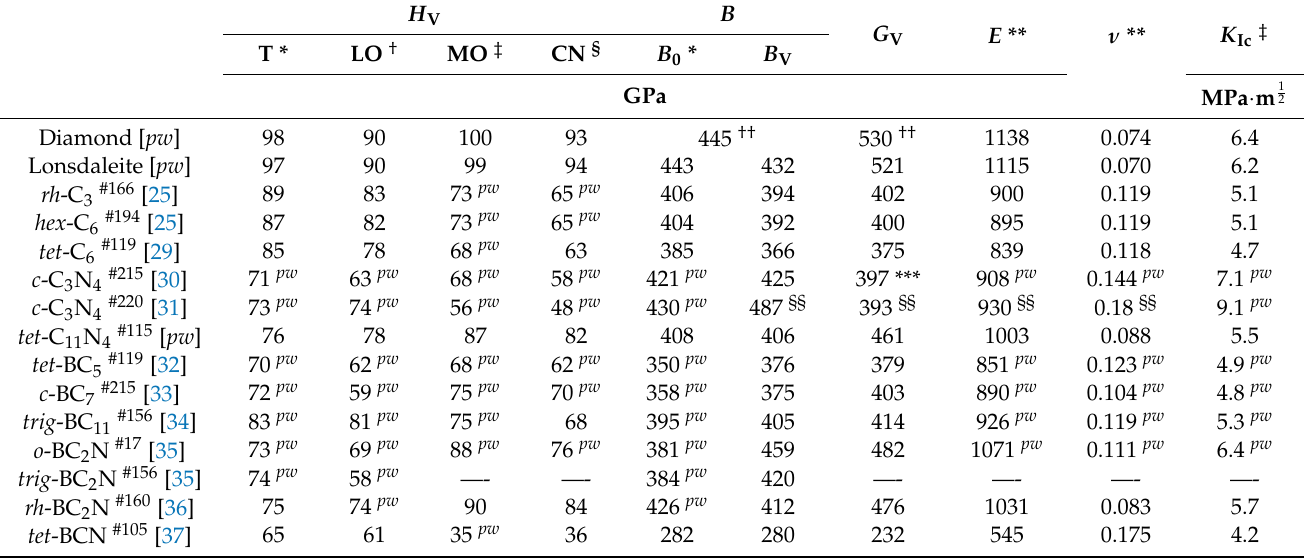
Table 2. Mechanical properties of (ultra)hard phases of the B–C–N system: Vickers hardness ( H V ),